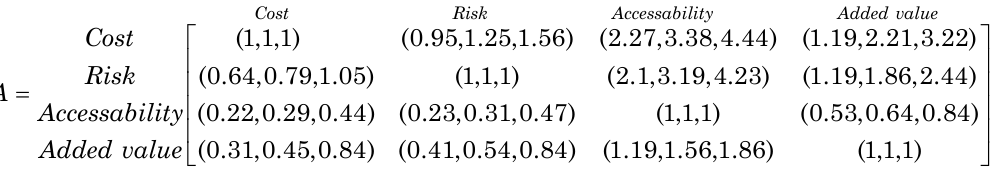
figure 5. structure of